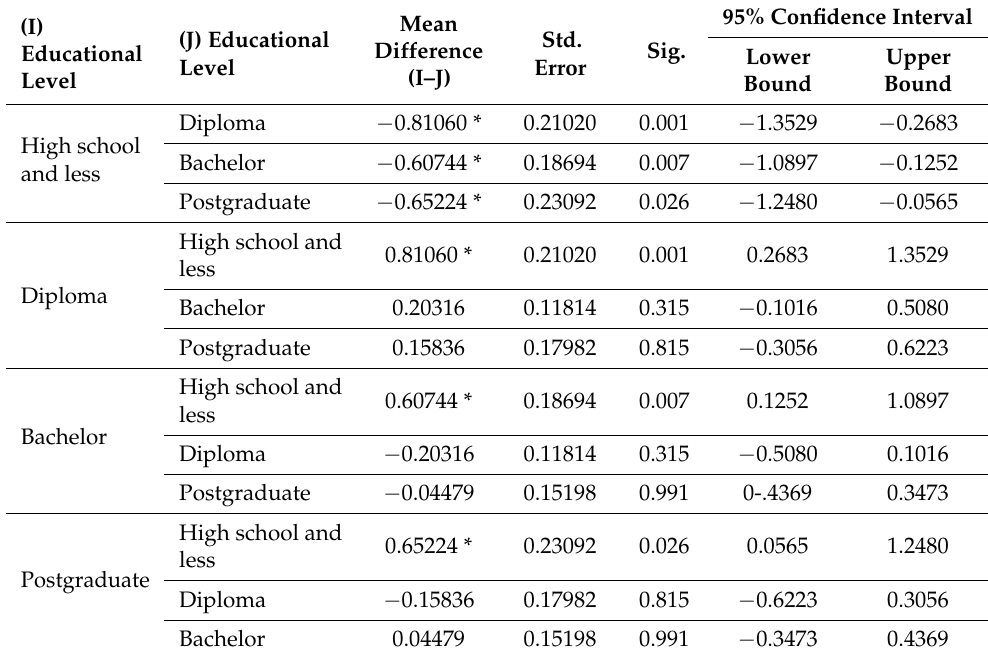
Table 11. Multiple comparisons analysis of the behavioral intention attributed to education.